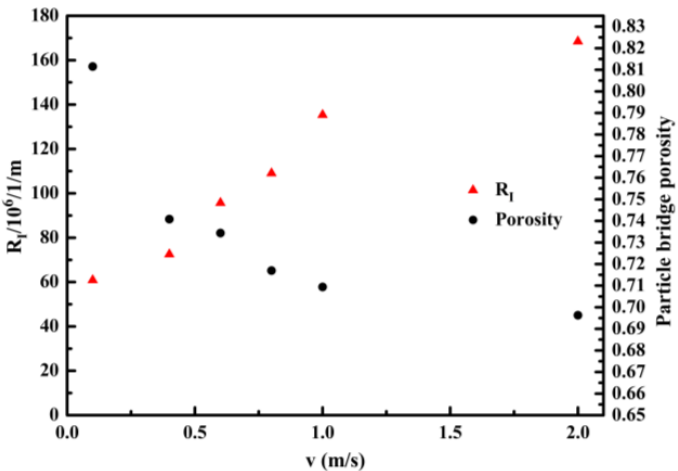
Figure 14. Effect of inlet velocity on interference resistance and particle bridge porosity.